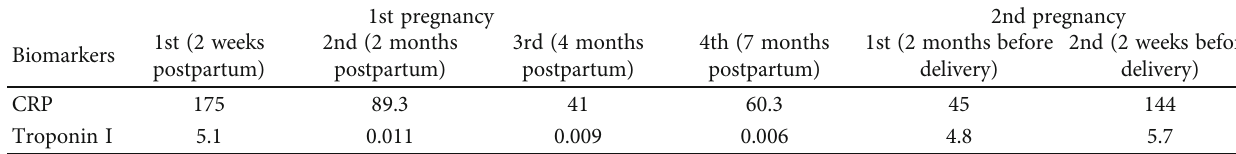
Table 1: Cardiac biomarkers and in fl ammatory markers during disease fl are.